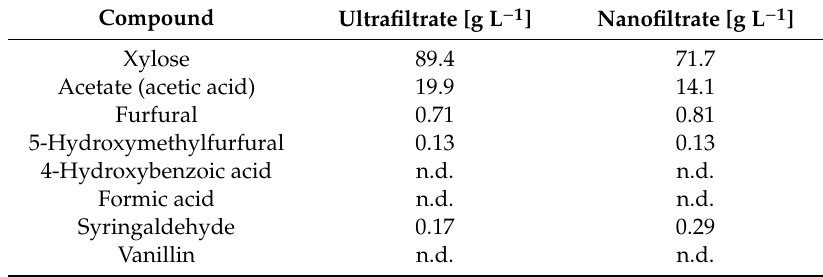
Compound Ultrafiltrate [g L − 1 ] Nanofiltrate [g L − 1 ] Xylose 89.4 71.7 Acetate (acetic acid) 19.9 14.1 Furfural 0.71 0.81 5-Hydroxymethylfurfural 0.13 0.13 4-Hydroxybenzoic acid n.d. Formic